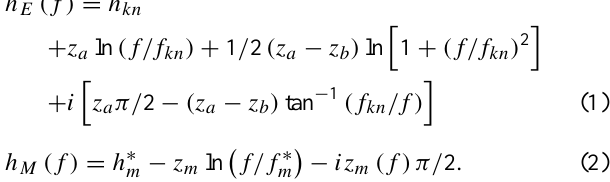
Fig. 1. Quiet and disturbed conductivity profiles with a scheme of how the propagation parameters are obtained.